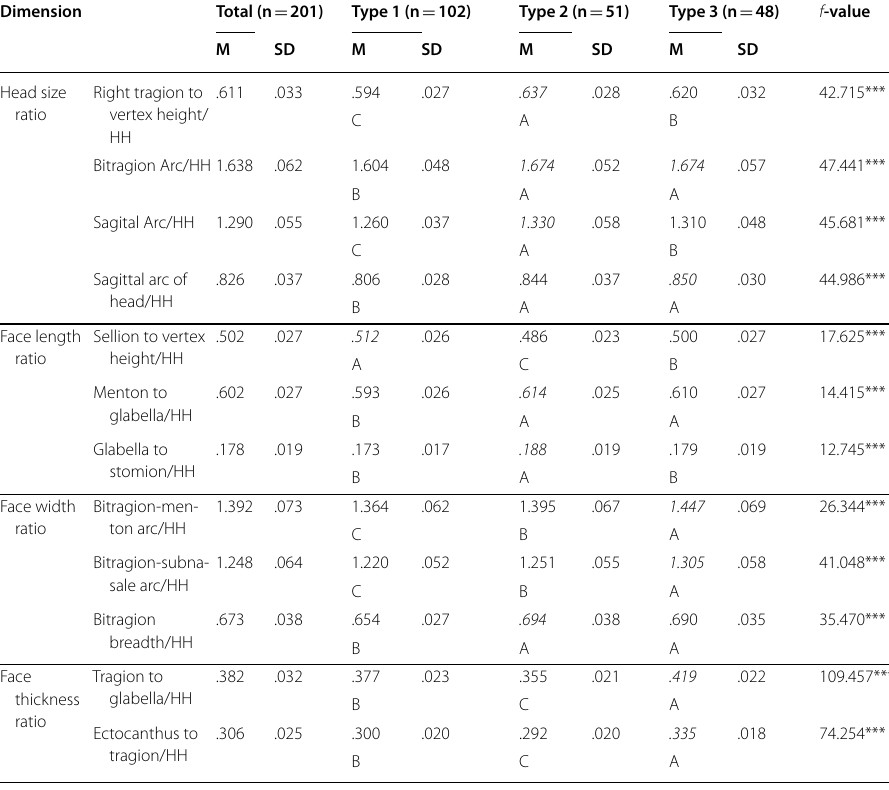
Table 6 Results of analysis of variance by factor score of index values (unit: mm)